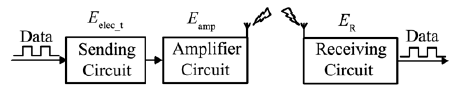
Figure 3. Radio energy consumption model.